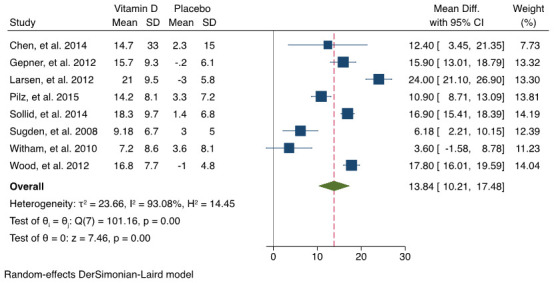
Forest plot of 25-hydroxyvitamin D changes from the baseline.The overall effect size estimate is represented by the red dashed line. SD, standard deviation; CI, confidence interval.